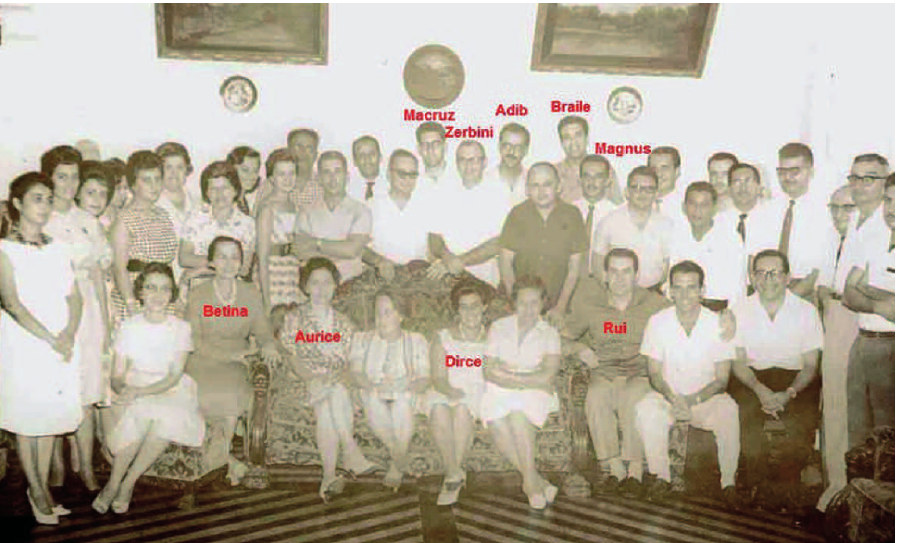
Fig. 6 – Caravana Zerbini (Belém,